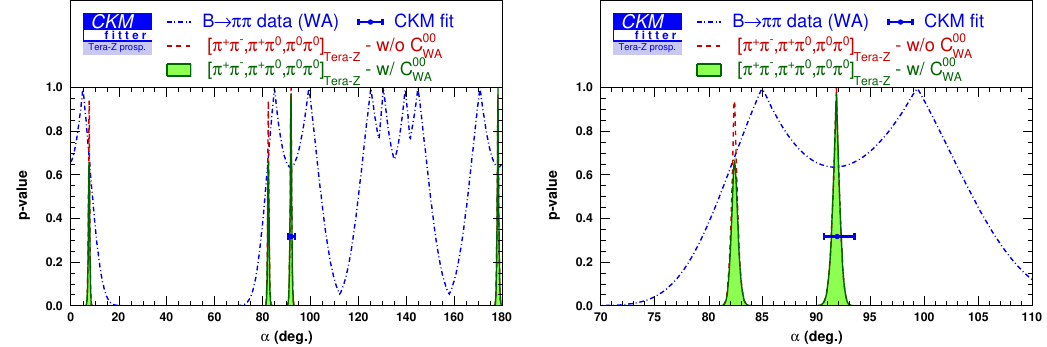
Figure 19 . p -value for α from B → ππ measurements using the current world average (dotted- dashed blue), within scenario 2 improving both neutral and charged modes without (dashed red) and with (solid green) the current measurement of C 00 . We show the scan over the whole range of CP α (on the left) and around the value favored by the global CKM fit (on the right). We take the baseline value a 00 = 0 . 950 ± 0 . 018 . CP